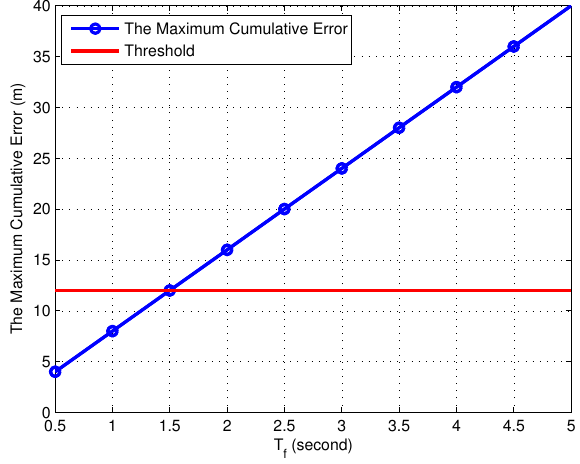
Figure 12. The impact of the fixed sleep period on the maximum